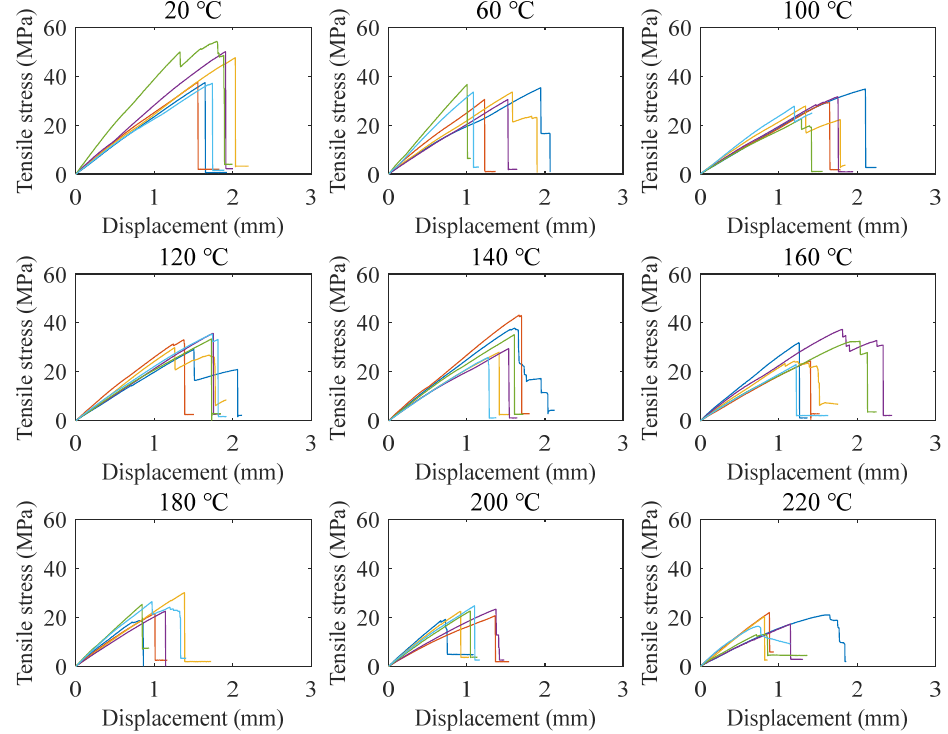
Figure 9. Stress-displacement responses of all the specimens in tension.